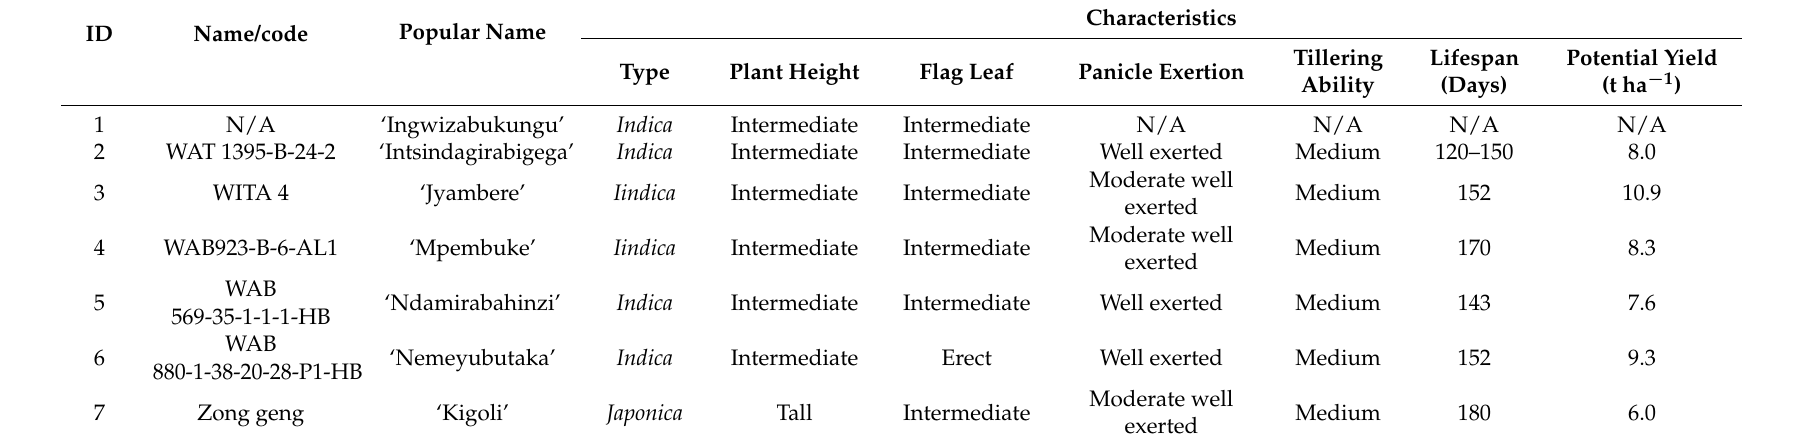
Table 1. Characteristics of rice cultivars included in this